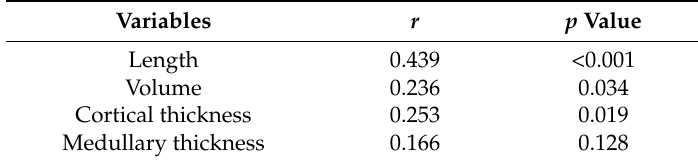
Table 3. Association between baseline eGFR and morphological